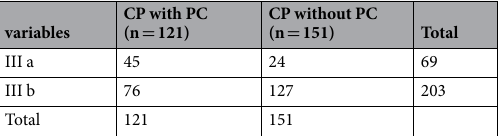
Table 2. comparison of subtpe of Type III CPPS patients with and without prostatic calcification(P < 0.01). CP = chronic prostatitis; PC = prostate calification The analysis of variance and paired t-test were used to analyze characteristics. Categorical variables were compared using the Pearson chi-square test. P < 0.05 was considered statistically